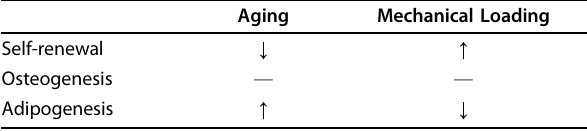
Table 1 Aging related changes in ADSCs and response to mechanical